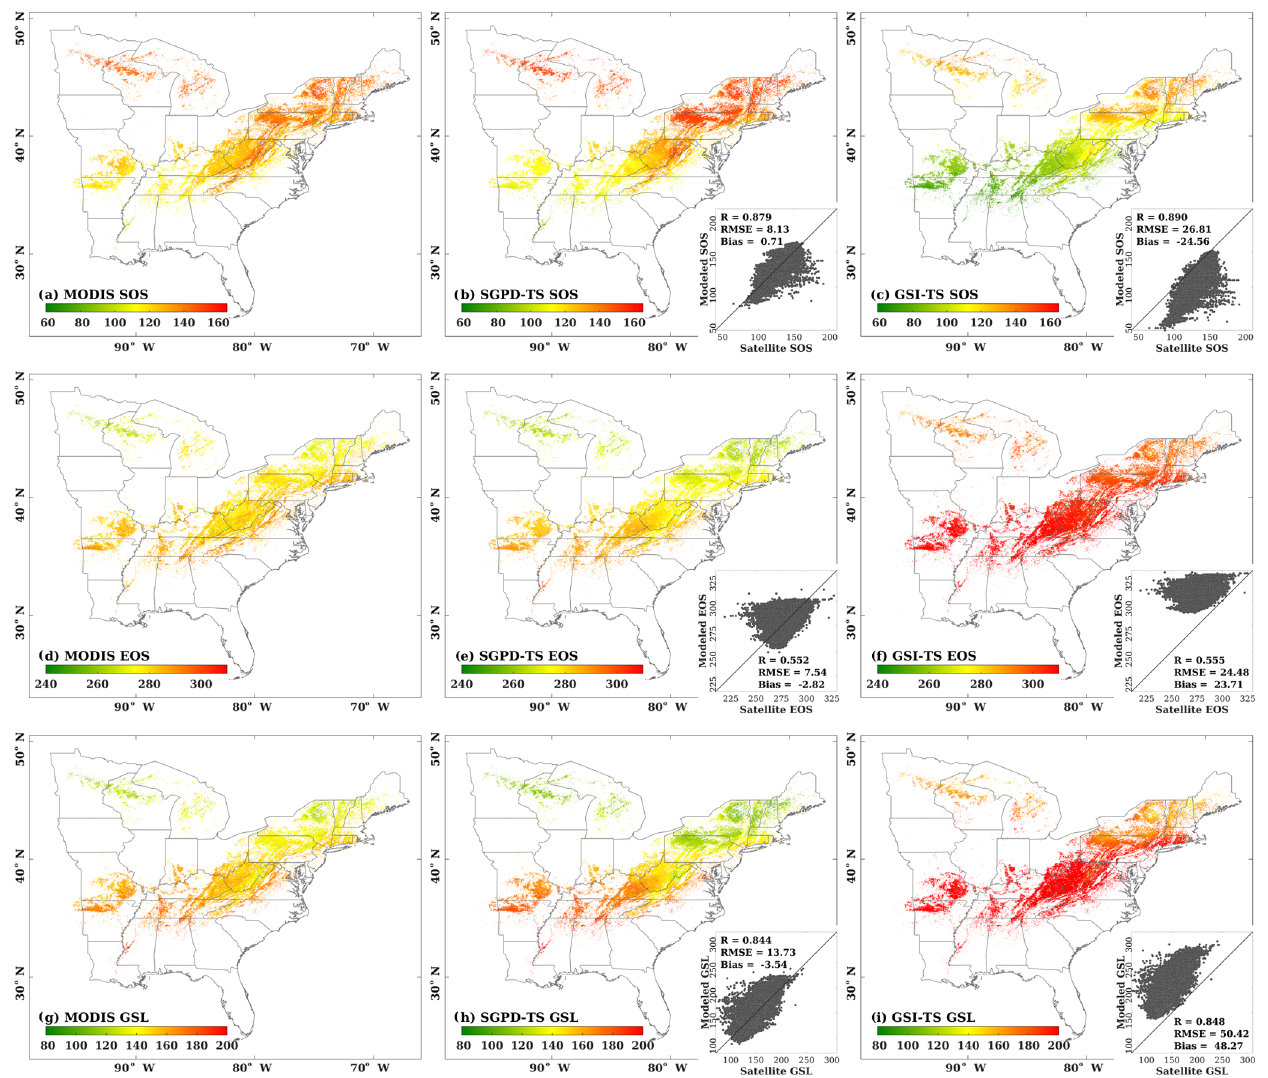
Figure 5. The spatial distributions are shown for (a) the start of the season (SOS) derived from MODIS LAI, (b) SOS derived from SGPD-TS LAI, (c) SOS derived from GSI-TS LAI, (d) the end of the season (EOS) derived from MODIS LAI, (e) EOS derived from SGPD-TS LAI, (f) EOS derived from GSI-TS LAI, (g) the growing season length (GSL) derived from MODIS LAI, (h) GSL derived from SGPD-TS LAI, and (i) GSL derived from GSI-TS LAI using 10-year (2001–2010) mean data across the eastern United States. The embedded subplots show comparisons between modeled and MODIS-derived phenological metrics for SOS, EOS, and GSL, respectively.